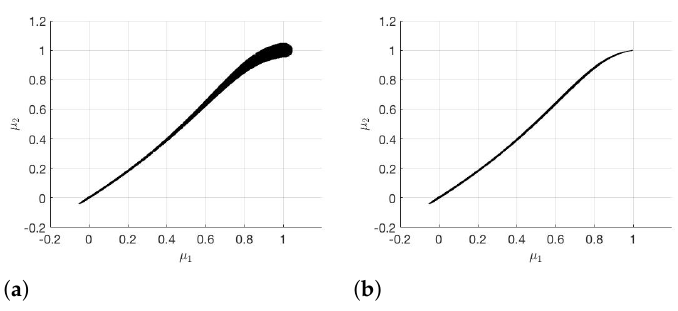
Figure 3. ( a ) P (cid:96) and ( b ) P (cid:96) generated with the subdivision algorithm. 2 1 The modified subdivision algorithm and RB-DEIM-solver lead to the results plotted in Figure 4.